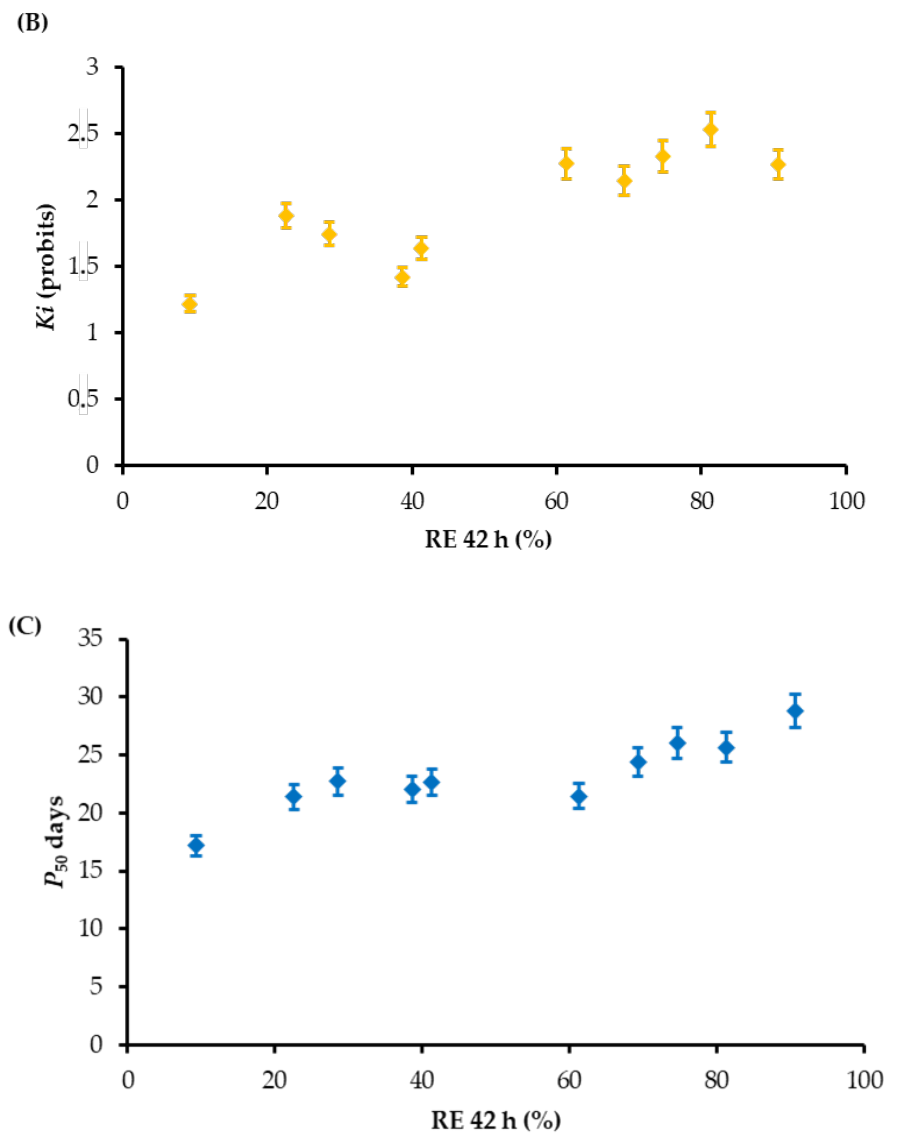
Figure 4. Correlation between radicle emergence (RE; % of seeds sown) at 42 h after germination was set up and normal germination percentage ( A ), Ki ( B ) and P 50 ( C ). SEM values are shown in each